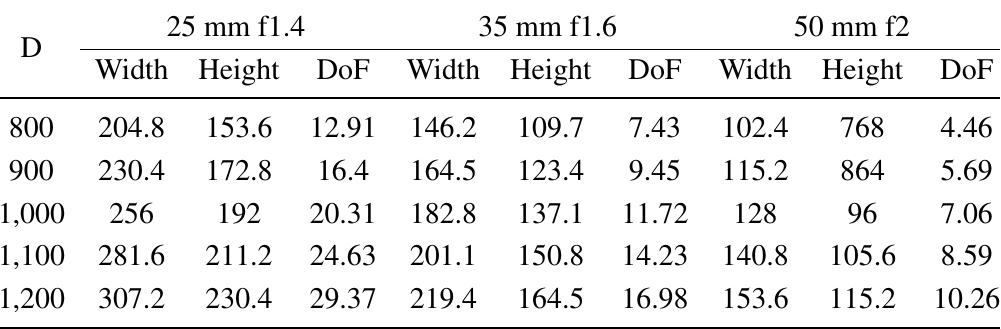
Table 1. Field of view and depth of field according to the kind of lens (values in